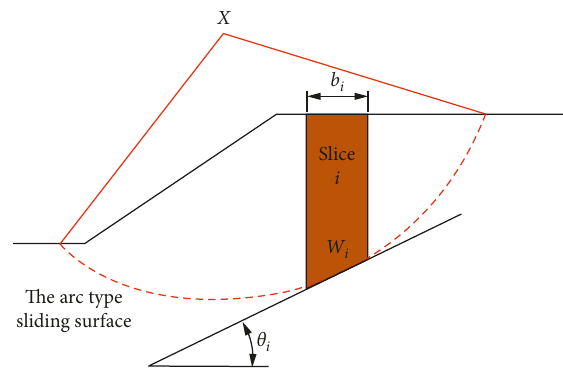
Figure 5: Schematic diagram of the simplified Bishop method.